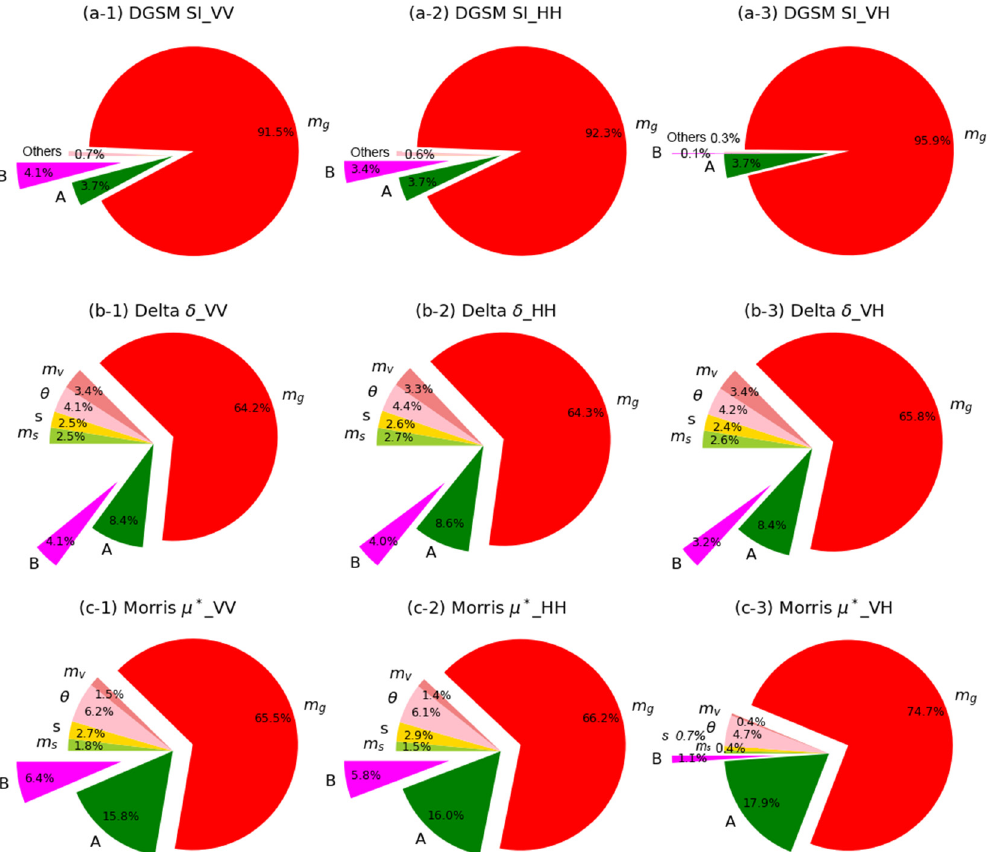
Figure 5. Parameter SIs from the three qualitative methods (DGSM, Delta test, and Morris) under the Park vegetation description scheme. The SIs are represented by SI, δ , and μ *, respectively.